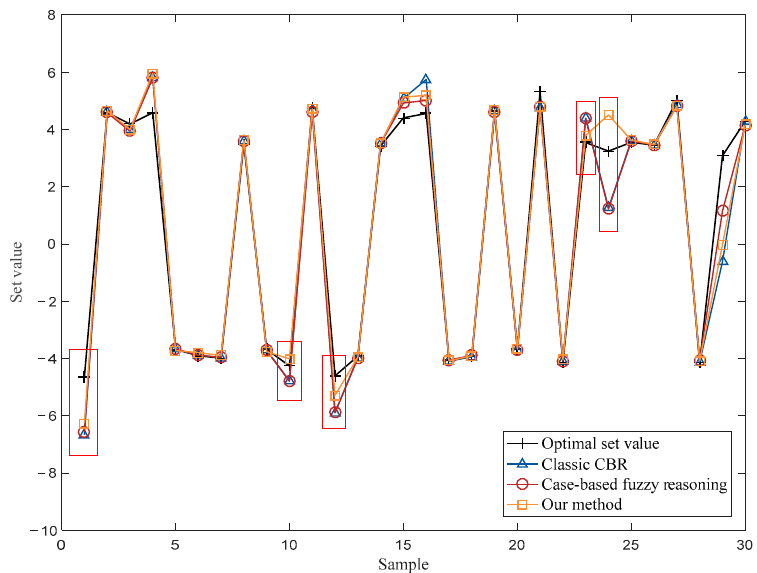
Figure 5. Set values of the testing dataset for numerical simulation.